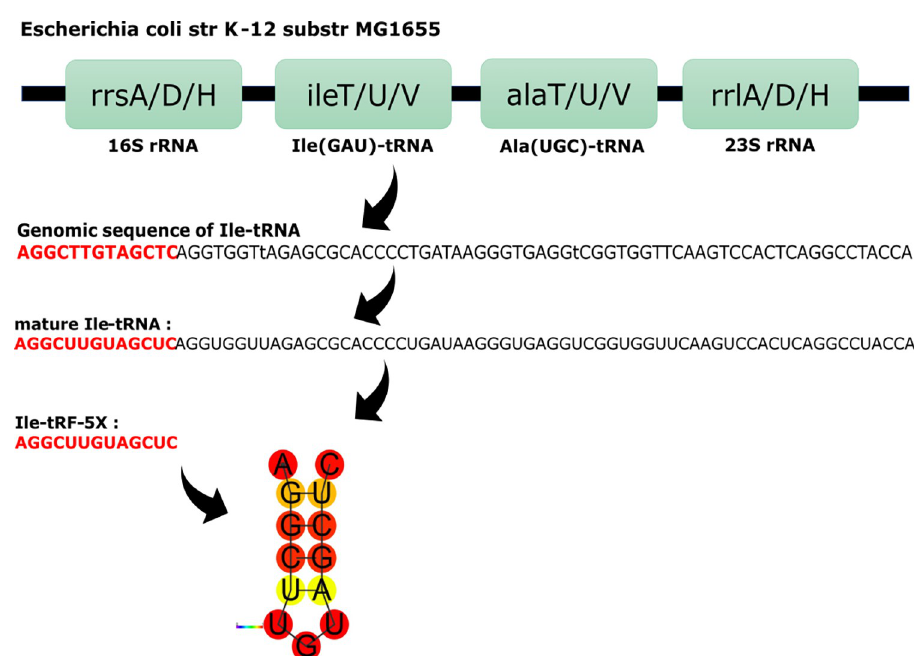
Fig 1. Simplified organization of the 3 operons containing the Ile-tRNA source of Ile-tRF-5X. isoleucine (Ile)-tRNA (GAT = anticodon) and alanine (Ala)-tRNA (TGC = anticodon) genes are found in the rrnA, rrnD and rrnH operons of E . coli K-12 genome. The Ile and Ala tRNAs are flanked by the 16S and 23s ribosomal RNAs (rRNAs). ileT , ileU , ileV genes all produce Ile(GAU)-tRNA. alaT , alaU , alaV genes all produce Ala(UGC)-tRNA. This diagram represents the three transcription units in one panel, under which the genomic sequence of Ile-tRNA and its mature sequence are presented. The 13-nt sequence in red represents Ile-tRF-5X, with its predicted secondary structure. The diagram does not show the endo and exonucleases involved in the maturation at each stage. The ribonuclease(s) involved in the cleavage of Ile-tRF-5X 3’ end have yet to be identified. Str, strain; substr, substrain; tRNA, transfer RNA.